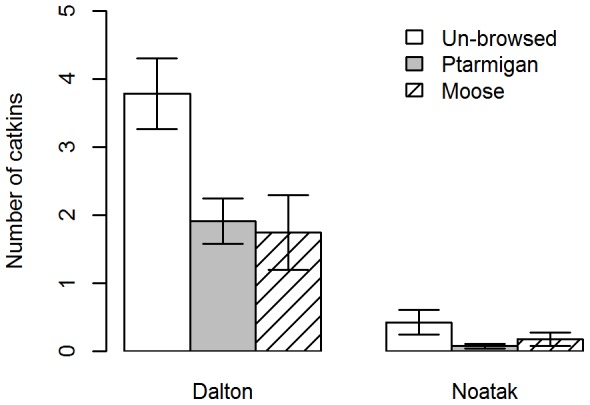
Number of catkins per branch of unbrowsed (U), ptarmigan-browsed (Lagopus lagopus, L. muta; P), and moose-browsed (Alces alces; M) feltleaf willows (Salix alaxensis) in the Dalton and Noatak study areas.Error bars denote standard error.